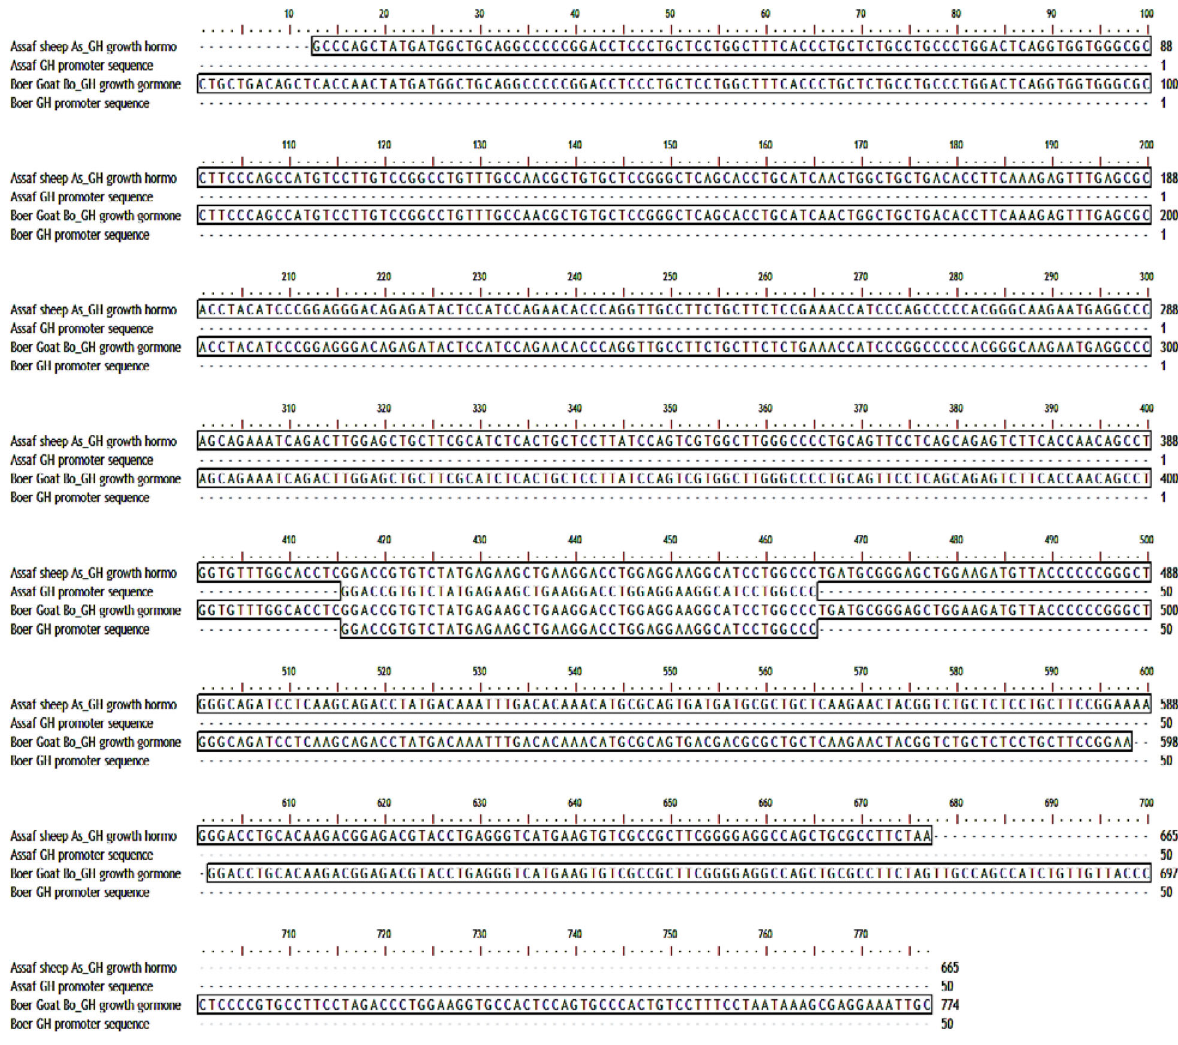
Fig. 8 Pairwise alignment of As_GH and Bo_GH cDNA sequences and their promoter